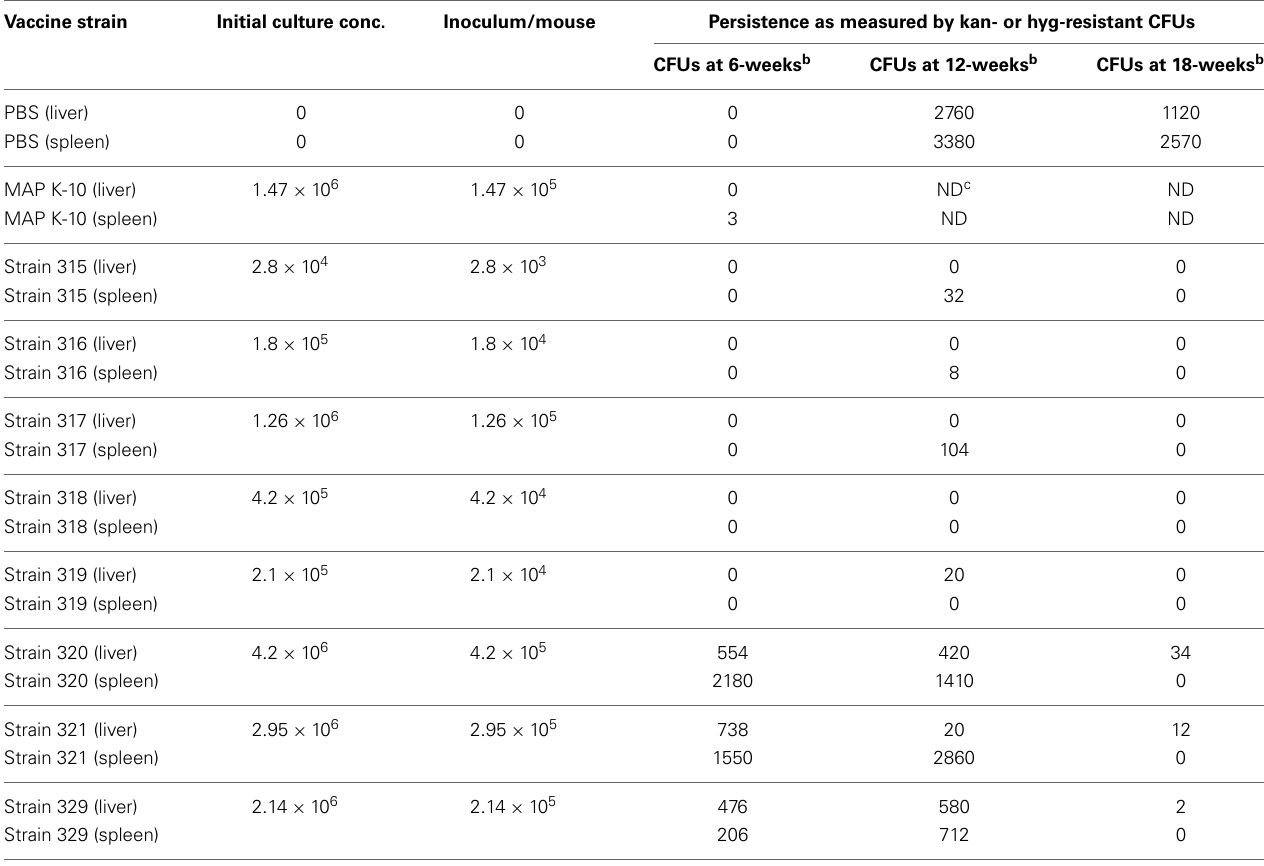
Table 2 | Persistence of vaccine strains a